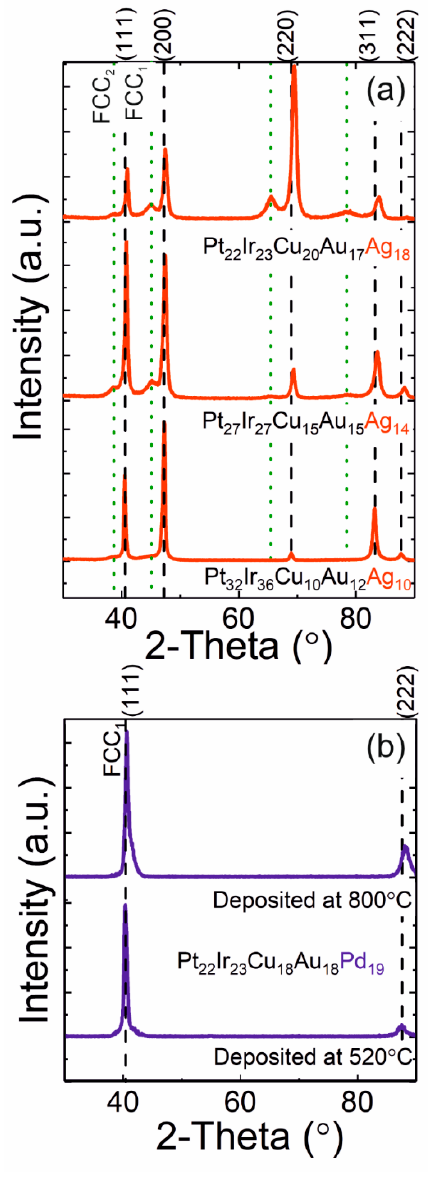
Figure 2. X-ray diffraction patterns depicting phase formation behavior of the PtIrCuAuAg ((a) and = Ag, Pd) material systems. FCC PtIrCuAuPd (b) (X = Ag, Pd) material systems. FCC 2 designates a secondary fcc phase formation. PtIrCuAuPd ( b ) (X 2 designates a secondary fcc phase